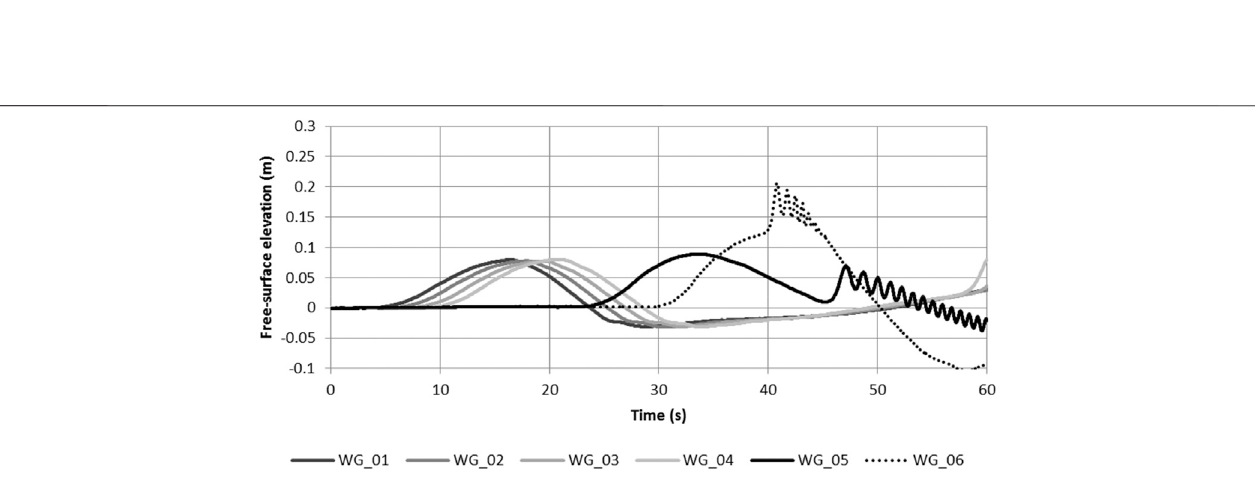
FIGURE 7 | T (cid:2) 20 s elevated wave propagating along the fl ume, WG_01 to 04 in a constant depth (7.0, 12.0, 17.0 and 22.0 m from TS respectively, h (cid:2) 1.0 m), WG_05 at the toe of the 1:20 slope (65.6 m from TS, h (cid:2) 1.0 m) and WG_06 on the 1:20 slope (75.6 m from TS, h (cid:2) 0.5 m).